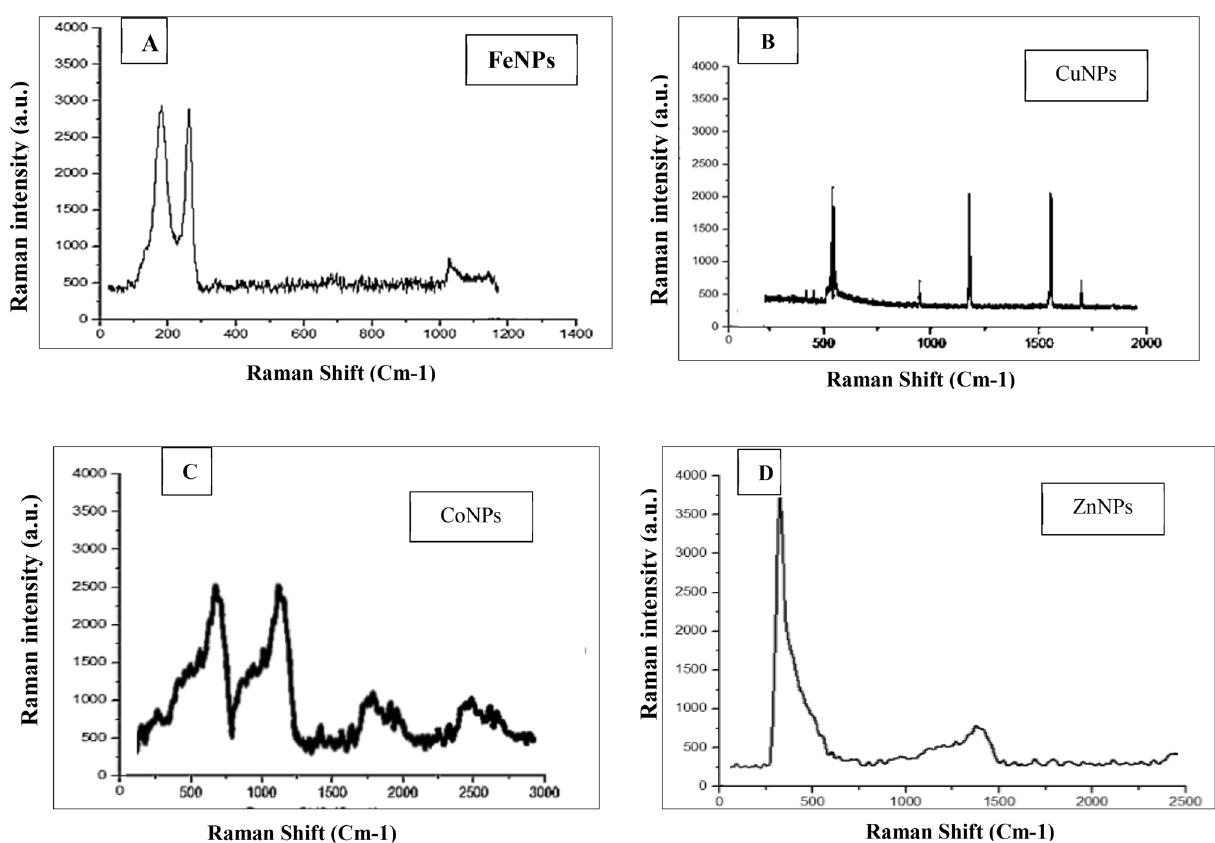
Figure 8. Raman spectra of FeNPs ( A ), CuNPs ( B ), CoNPs ( C ) and ZnNPs ( D